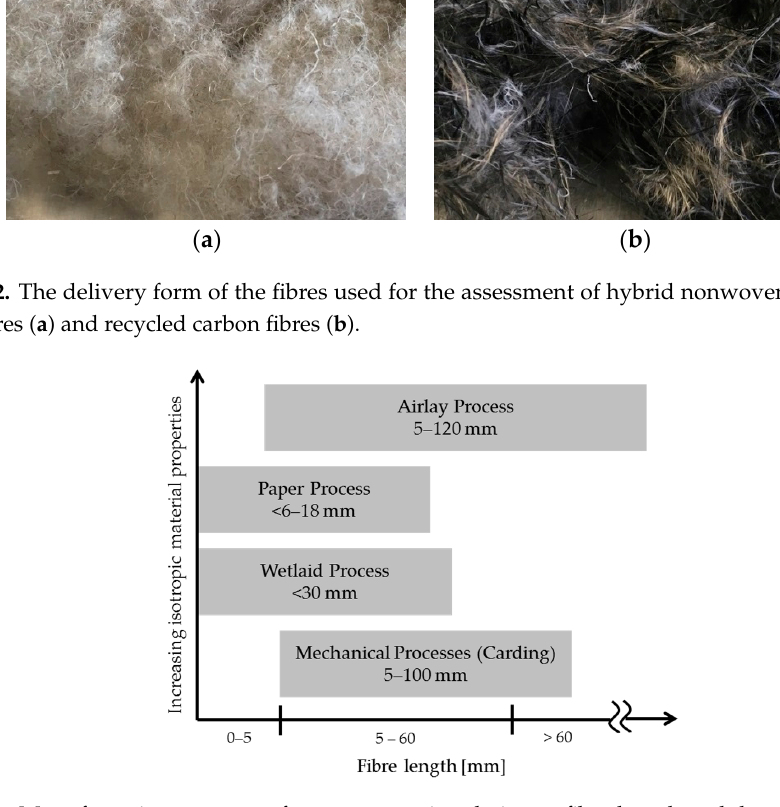
Figure 2. The delivery form of the fibres used for the assessment of hybrid nonwoven in this study. Flax fibres ( a ) and recycled carbon fibres ( b ).